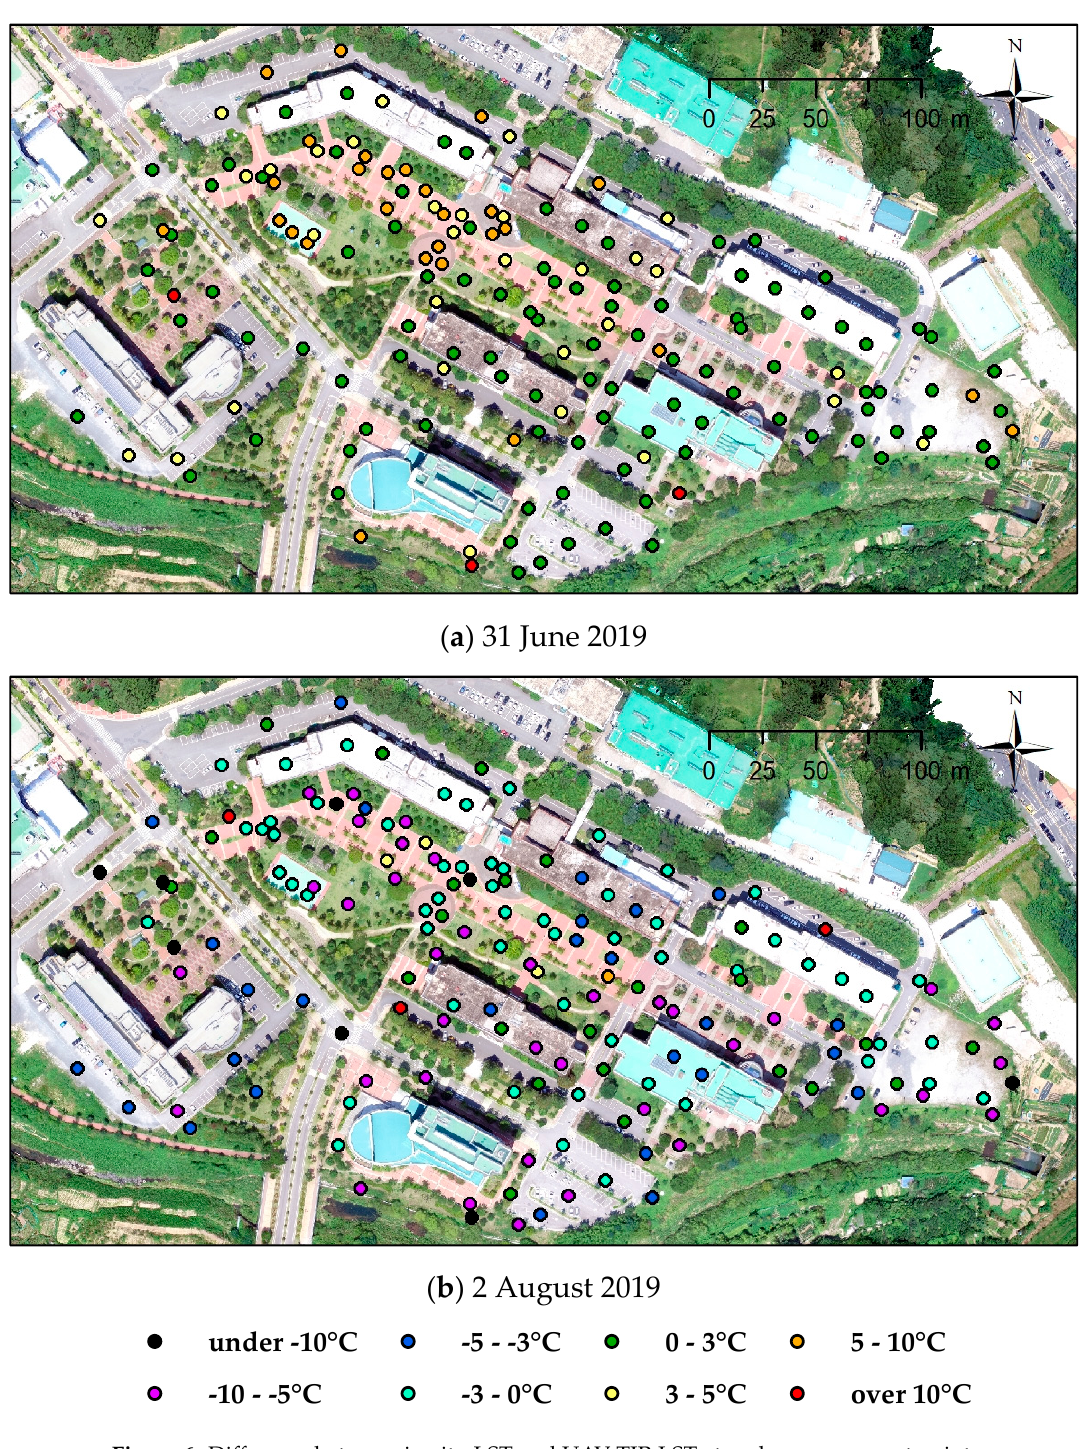
ff erence between in-situ LST and UAV TIR LST at each measurement Figure 6. Difference between in-situ LST and UAV TIR LST at each measurement point. Figure 6. Di